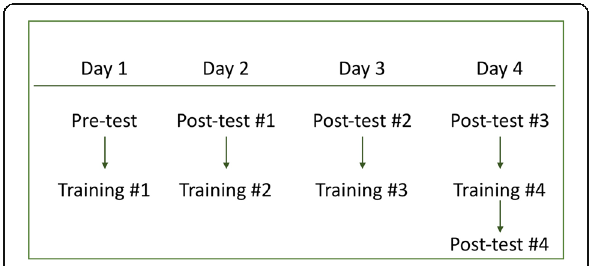
Fig. 2 The training and testing schedule used in experiments 1A,